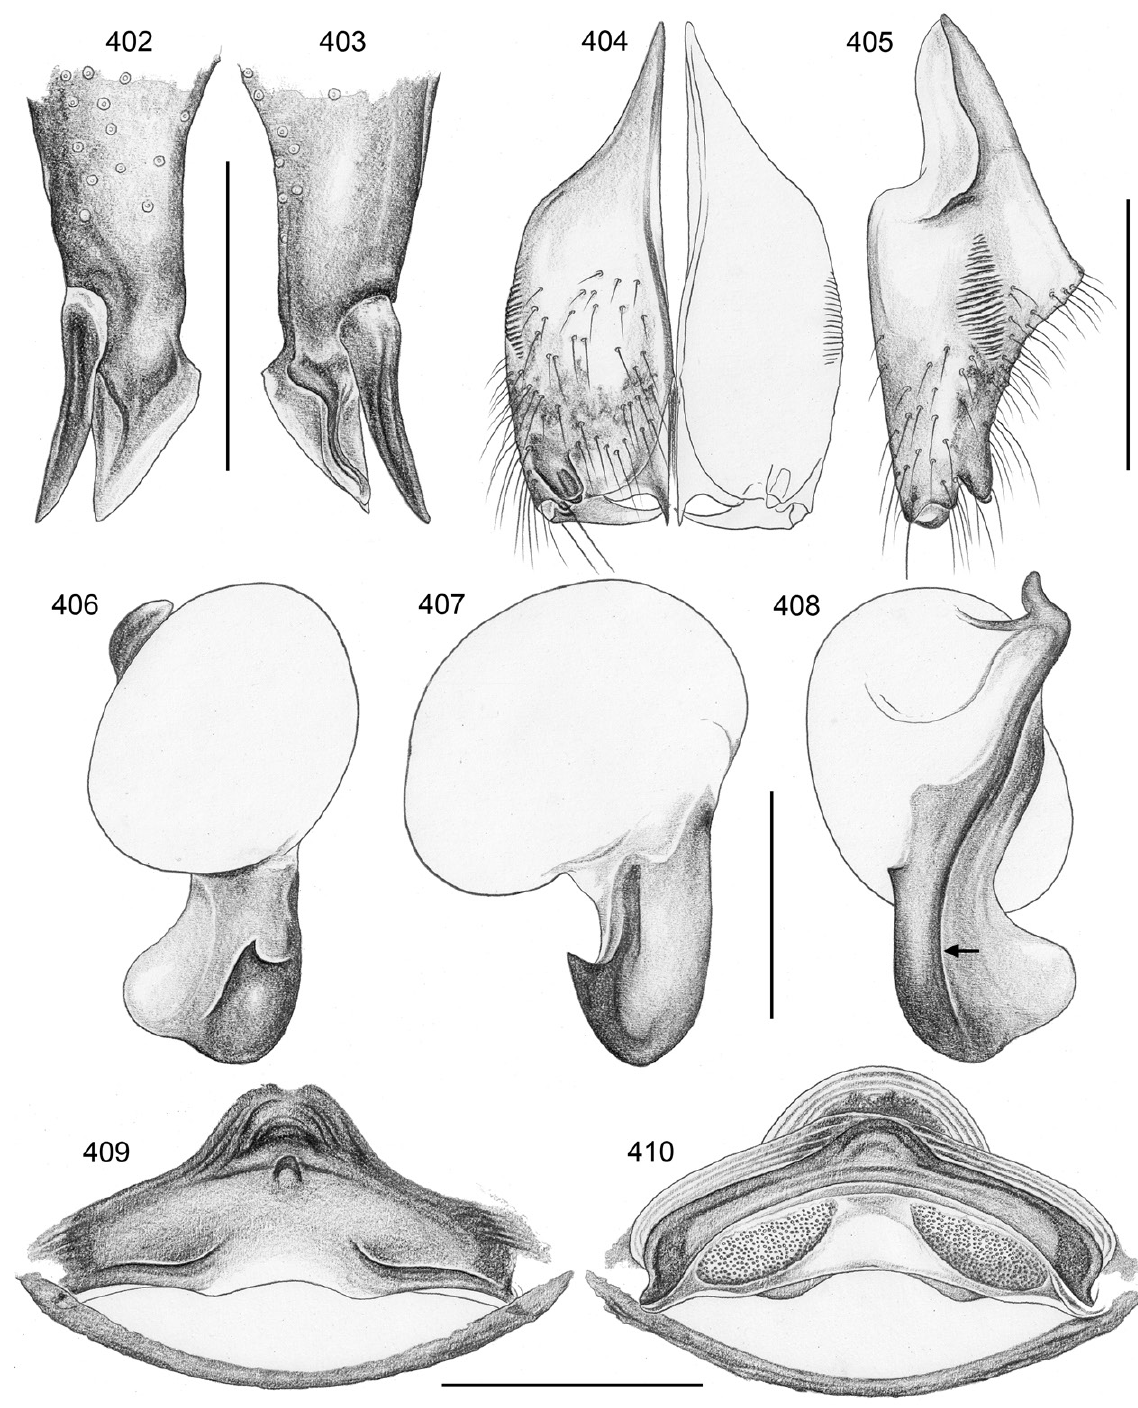
Figs 402–410. Crossopriza sahtan sp. nov.; male and female from Oman, above Wadi Sahtan (ZFMK Ar 22394). 402–403 . Left procursus tip, prolateral and retrolateral views. 404–405 . Male chelicerae, frontal and lateral views. 406–408 . Left genital bulb, prolateral, dorsal, and retrolateral views; arrow: retrolateral ridge. 409–410 . Cleared female genitalia, ventral and dorsal views. Scale bars: 402–403, 406–408 = 0.3 mm; 404–405, 409–410 = 0.5